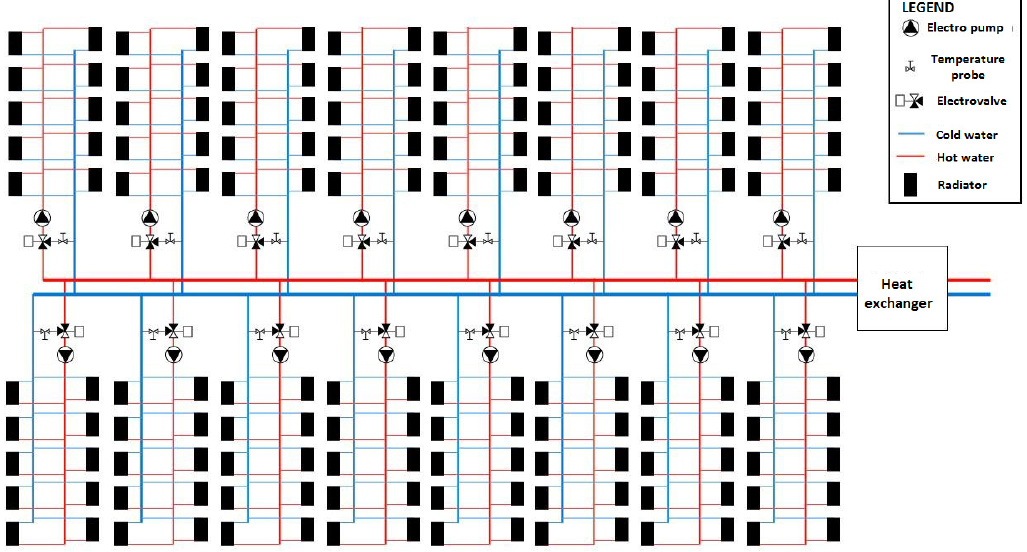
Figure 4. The functional scheme of the solution, adopted for a students’ dormitory.